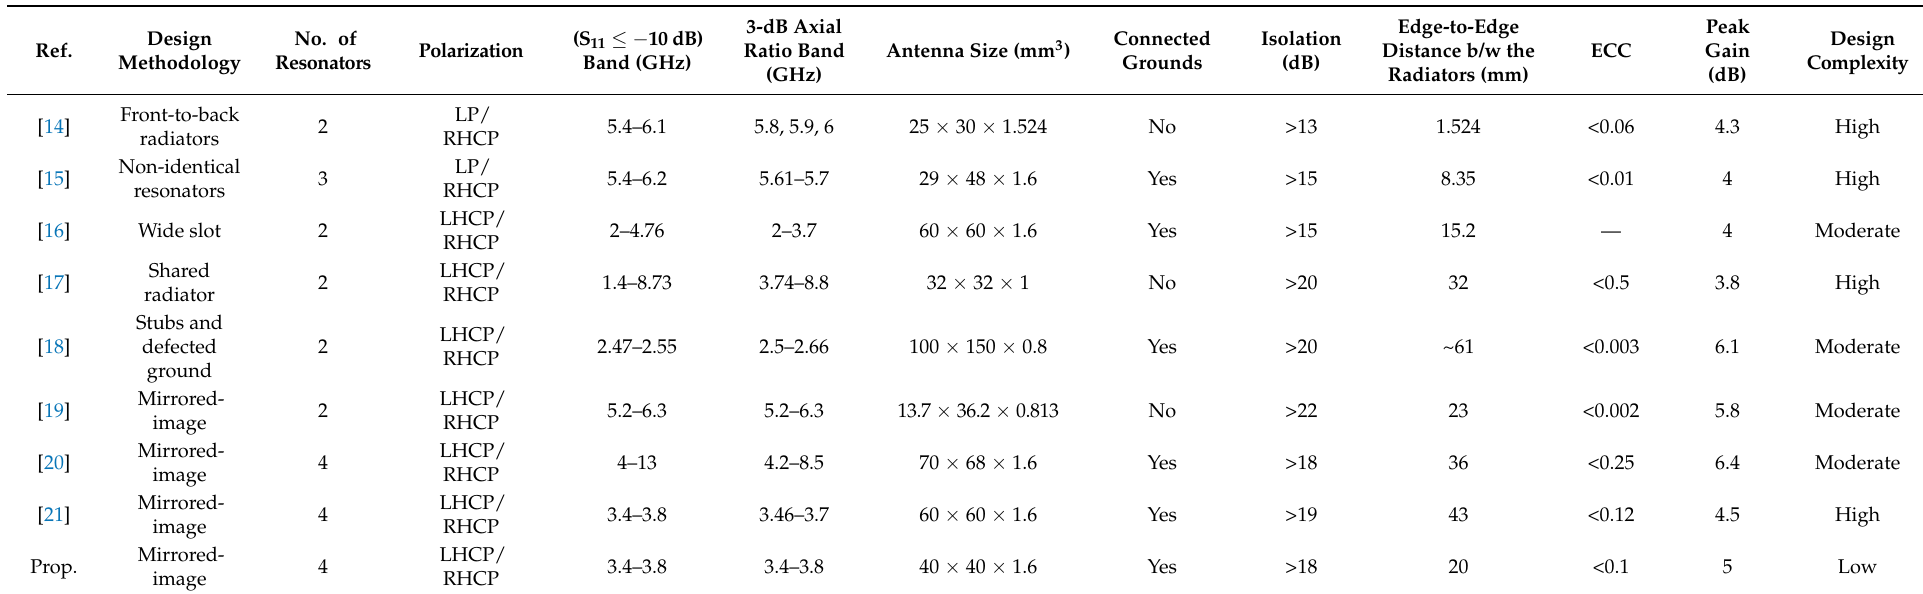
Table 2. Performance comparison with the reported CP MIMO